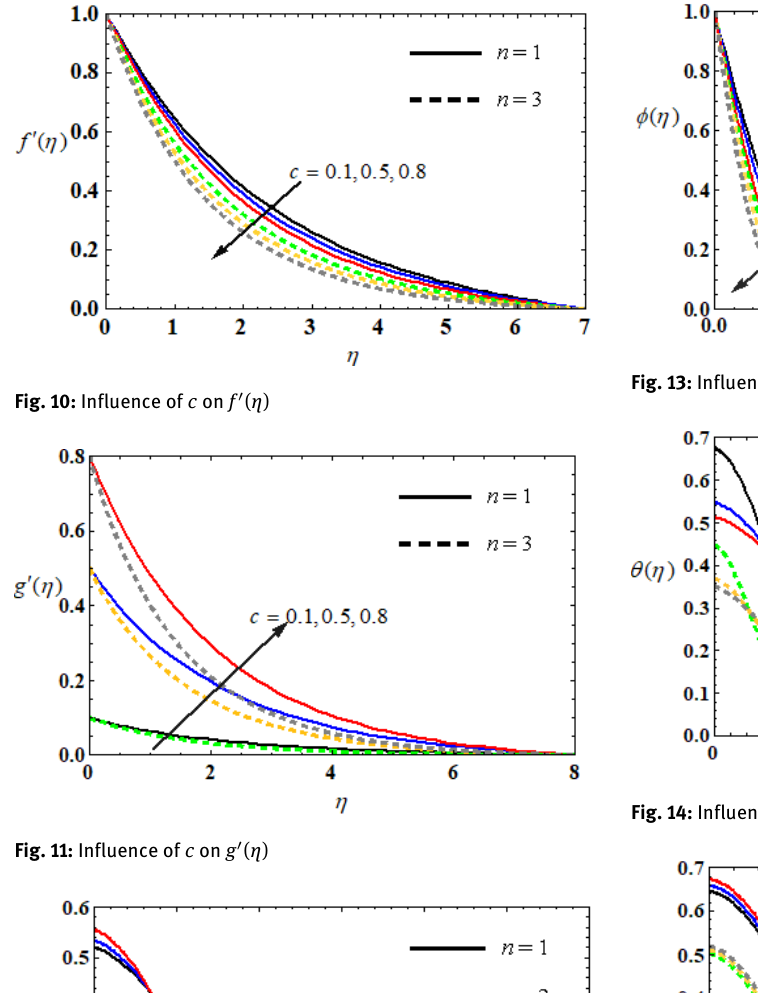
Fig. 11: Influence of c on g (cid:48) ( η )